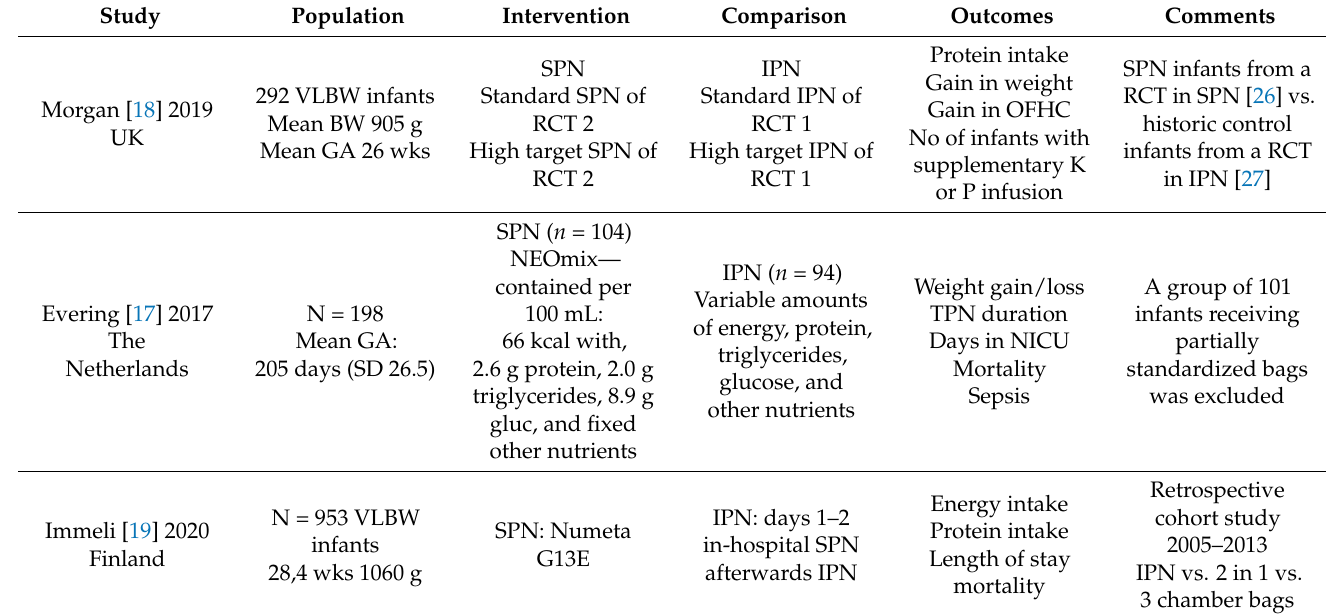
Table 5. New identified studies. All new studies are nonrandomized trials using historical controls (LoE 2-). (Standardized parenteral nutrition (SPN), individualized parenteral nutrition